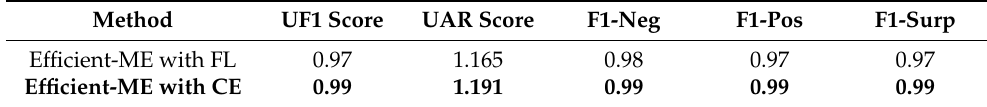
Table 7. Loss function evaluation for Efficient-ME pre-trained on imbalanced FER2013. Method UF1 Score UAR Score Efficient-ME with FL Efficient-ME with